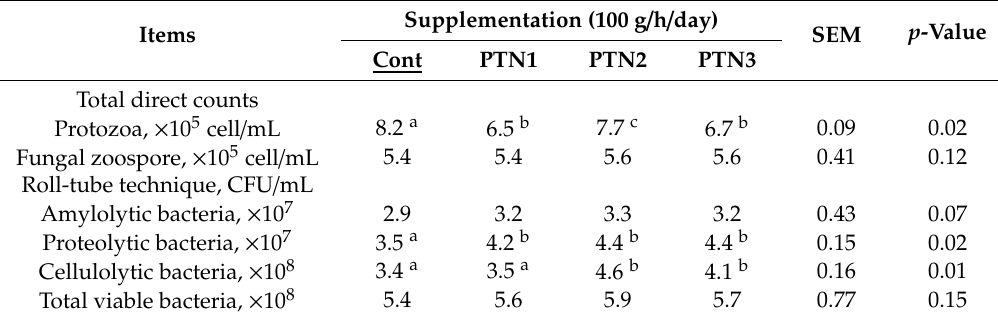
Table 4. E ff ects of some sources of phytonutrients (PTN) on the rumen protozoa, fungal zoospore,